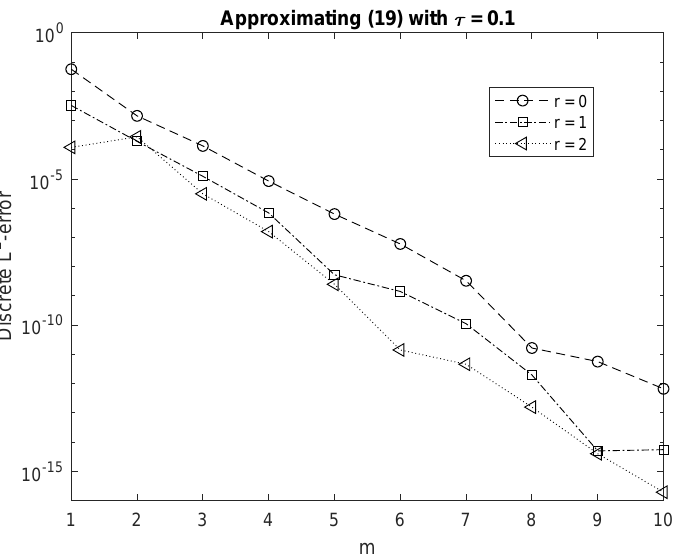
Figure 9. Discrete L 2 -error against number of Krylov iterations when approximating (6) for the data in Section 2.1 through (19) using purely rational Krylov method for τ = 0.1, r = 0,1,2 and fixed h = 10 − 3